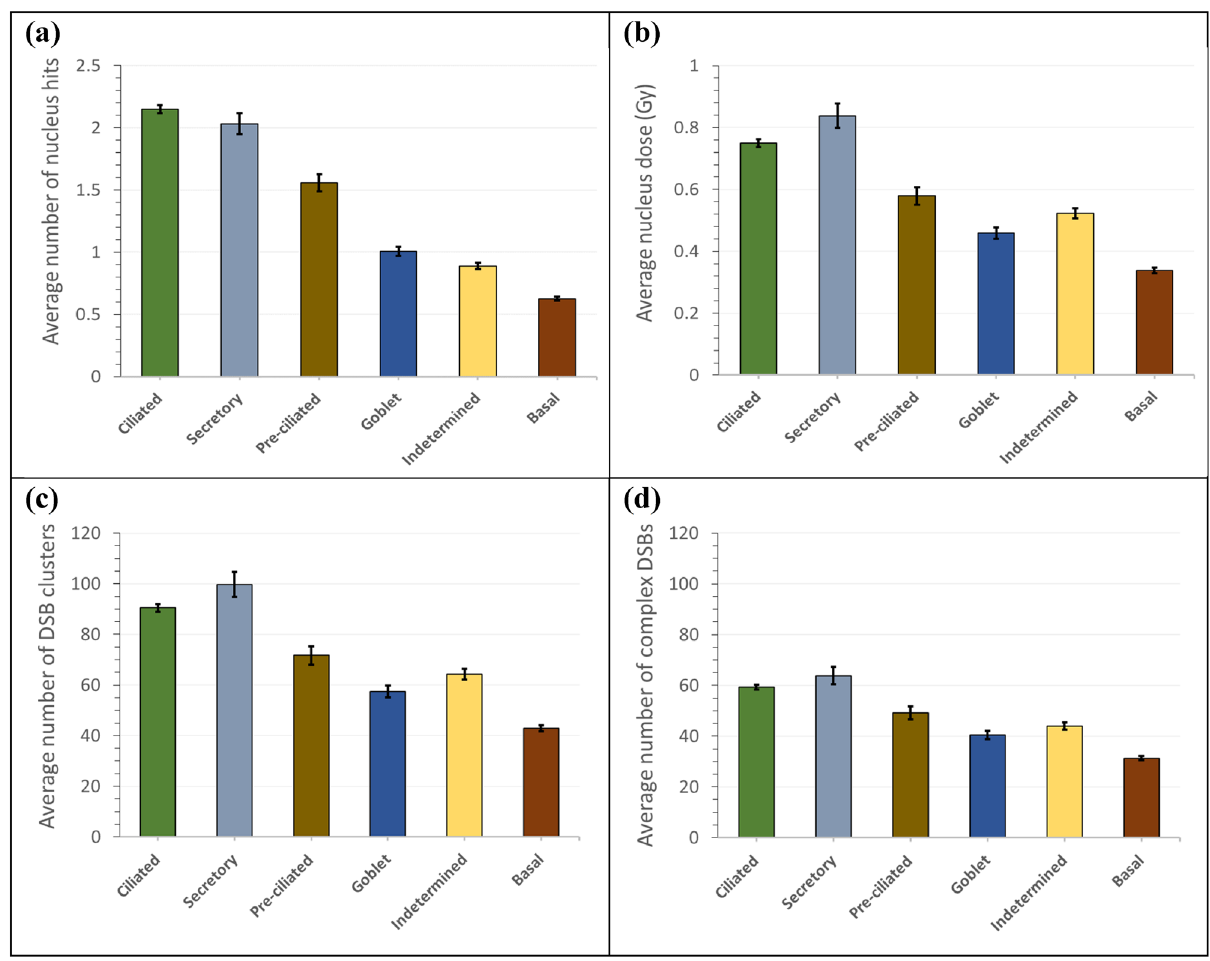
Figure 9. Average values of ( a ) number of nucleus hits, ( b ) nucleus dose, ( c ) number of DSB clusters, and ( d ) number of complex DSBs due to 0.1 alpha emission from radon progeny in a 5 µ m 3 mucosal layer. Each bar indicates one standard deviation of the mean